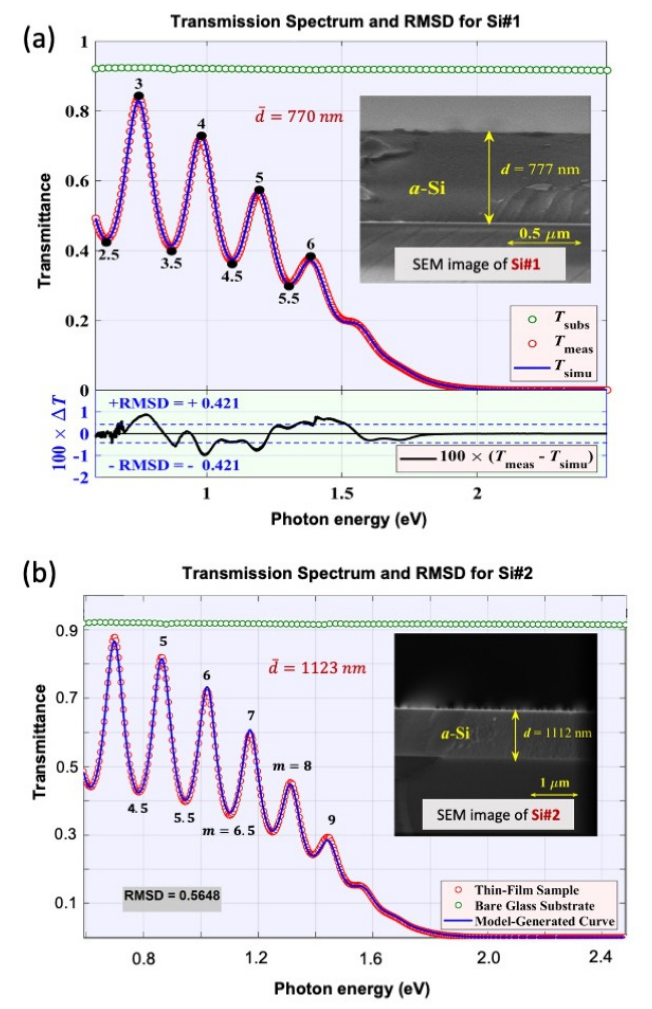
Figure 4. Experimental and best-fit transmittance spectra of the representative RFMS- a -Si thin- film samples, Si#1 ( a ) and Si#2 ( b ), respectively. Additionally, the difference between the TLUC- model-generated transmission spectrum and the as-measured transmission spectrum, ∆ T , for both specimens. The excellent comparison between the simulated and experimental normal-incidence transmission spectra are clearly illustrated in this figure. The cross-sectional SEM micrographs for Si#1 and Si#2 are also displayed in this figure, as insets. The measured values of film thickness are marked in the insets. Moreover, the values of some FP-interference order numbers are indicated in the figure, together with the calculated values of ¯ d . The very-low computed values of FOM are also inserted into the figure, for the two samples Si#1 and